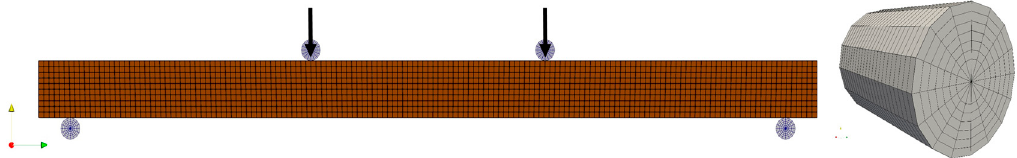
Figure 7. Left: 3D-FEM model for a four-point bending test set-up. Right: 3D-Mesh of load cells/supports.